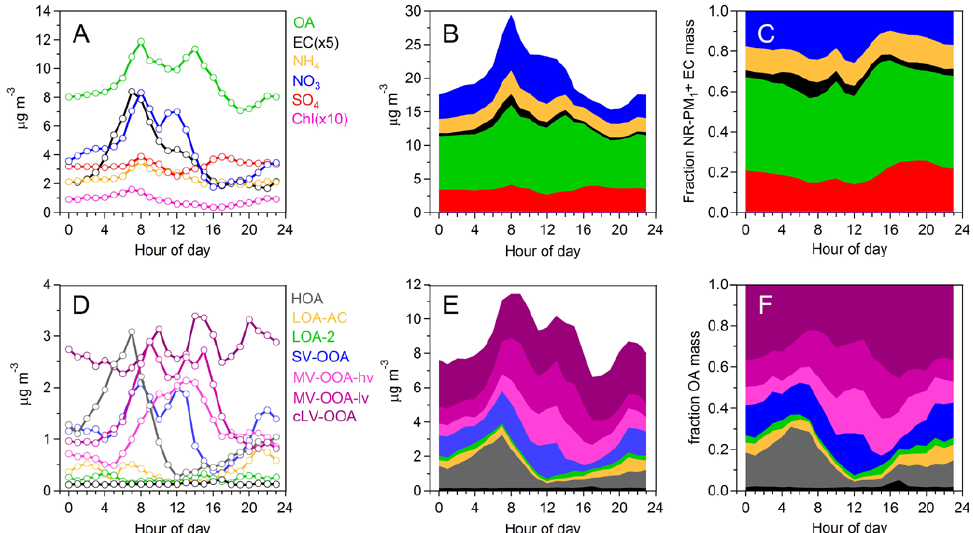
Fig. 11. Hourly average concentrations of major NR-PM 1 and EC (a–c) , and OA components (d–f) identified from the 7-component solution during SOAR-1. Note that the absolute concentration of chloride has been multiplied by a factor of 10 in (a) for clarity. Diurnal profiles in (b) and e are stacked to show the overall composition of NR-PM 1 and OA, respectively, while profiles in (c) and (f) show the relative contribution of major NR-PM 1 and EC to HR-AMS and identified PMF components to OA, respectively. The black trace at the bottom of panels (d) – (f) is the PMF